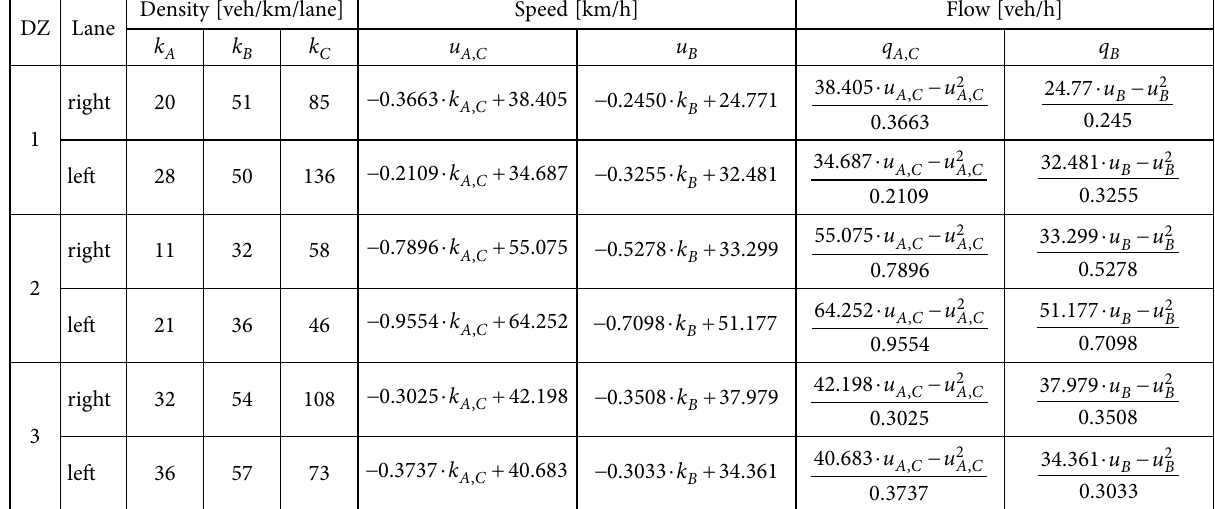
Table 3. q , u and k calculation models for before bottleneck, at the bottleneck and after bottleneck road sections Density [veh/km/lane] DZ Lane